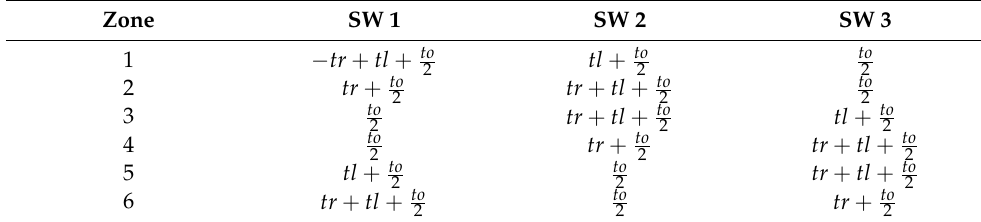
Table 1. Duty ratio in zones.